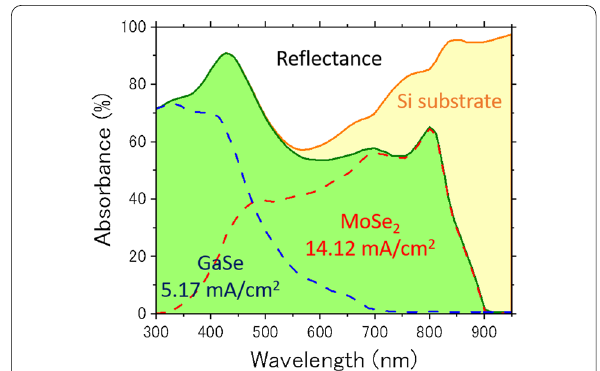
Fig. 7 The simulated absorbance spectra of GaSe/MoSe 2